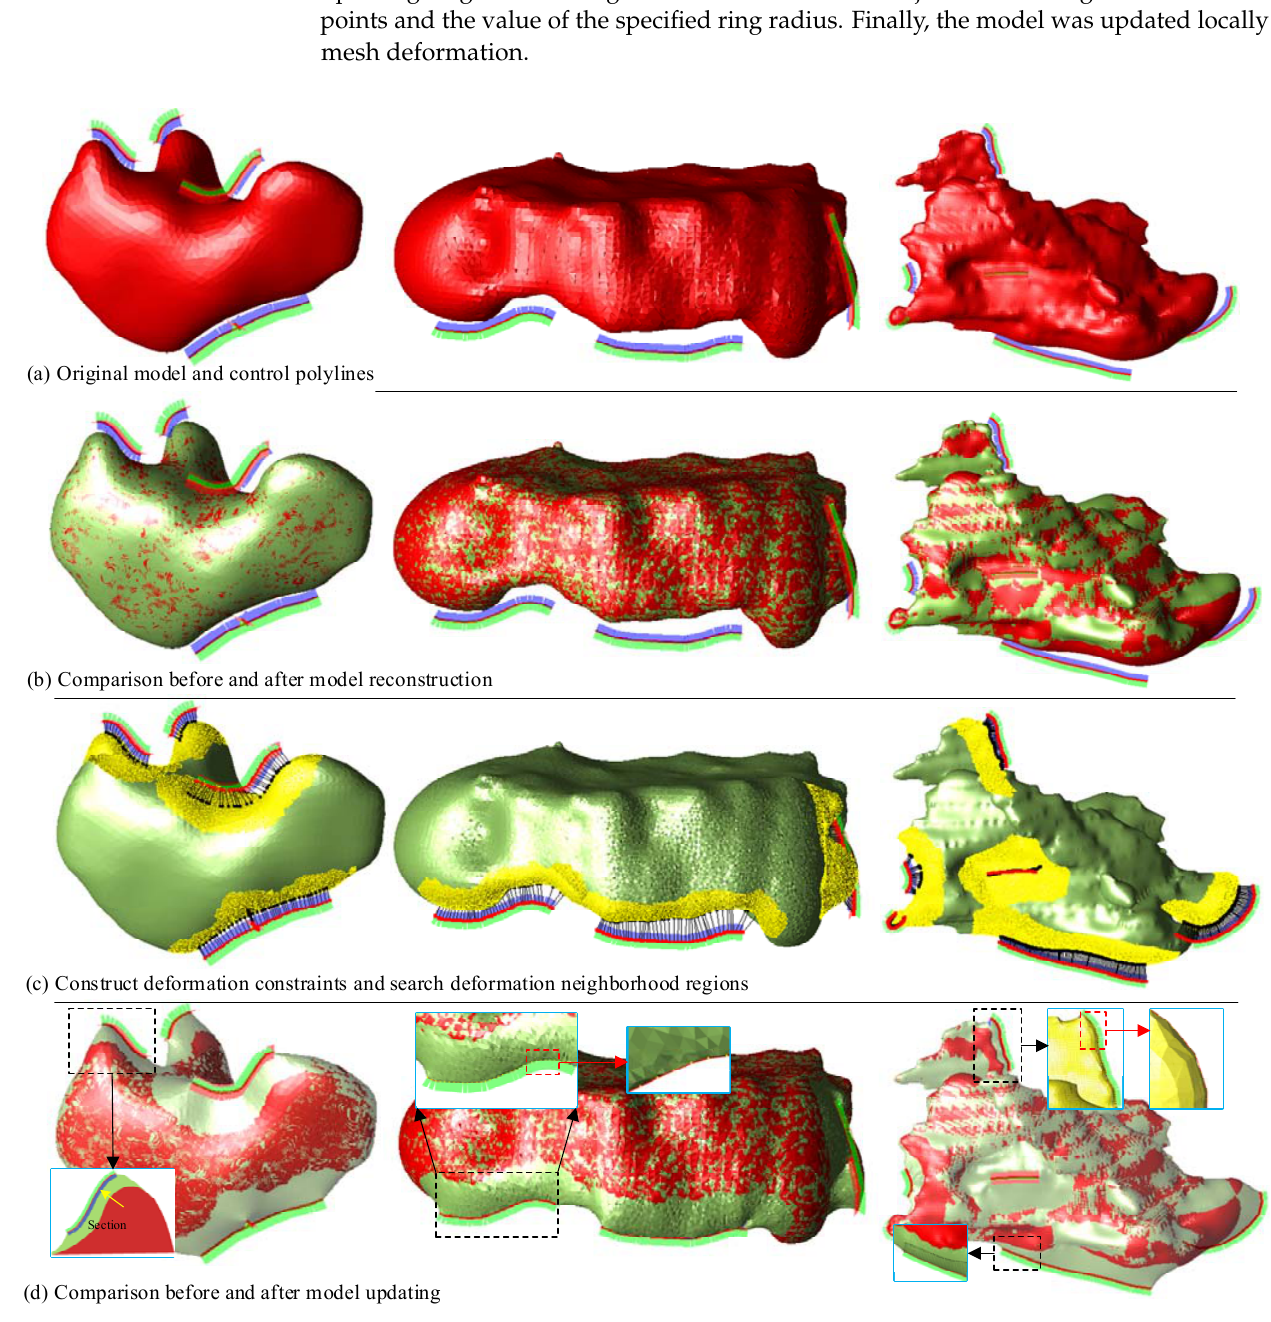
Figure 8. Three examples of the local updating of orebody models ( a – d ): (1) the first example; (2) the second example; (3) the third example.